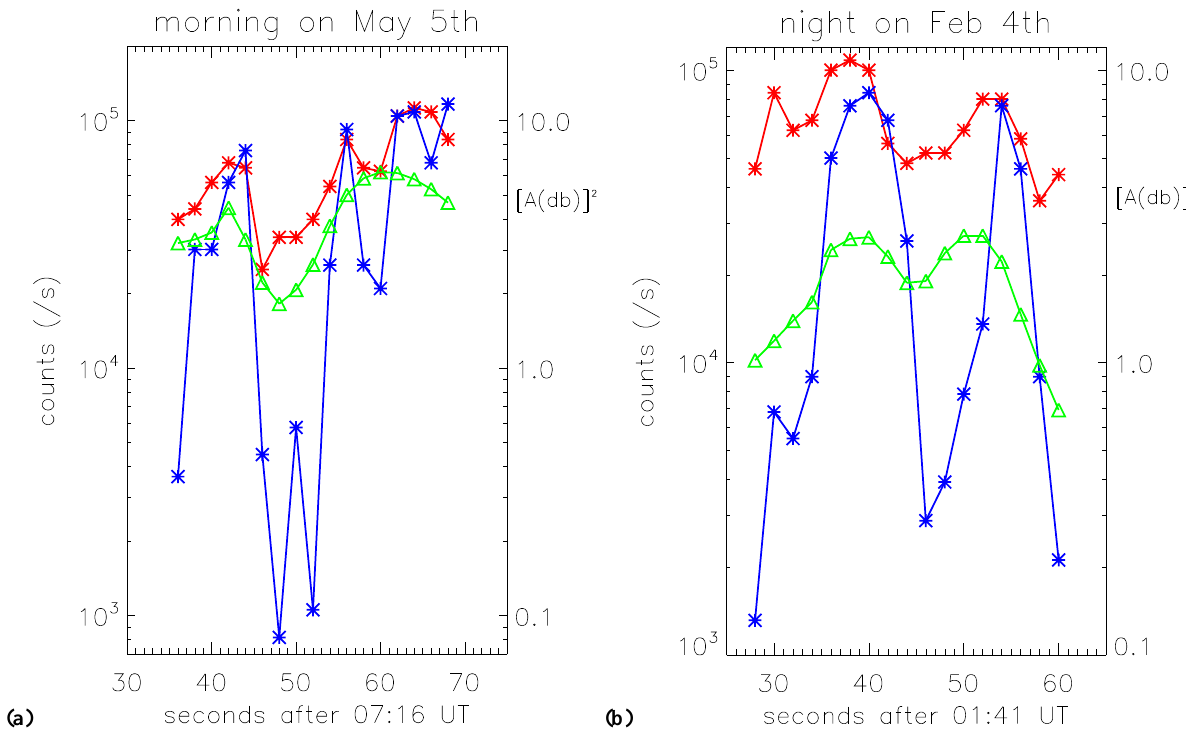
Figure 4: Comparison of [A(db)] 2 (green) with precipitated (blue) and trapped (red) count rates at 30 keV, for the times of the overpasses by (a) NOAA-12 from 07:16:34 to 07:17:10 UT on day 125 (May 5th), and (b) NOAA-14 from 01:41:27 to 01:42:00 on day 35 (Feb 4th), both in 1995, in the morning and night sectors, respectively.